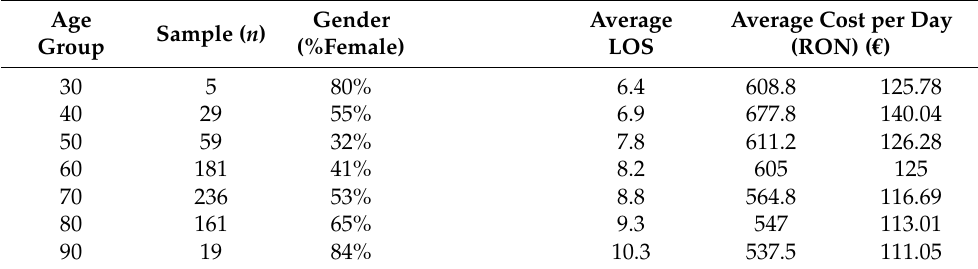
Table 2. Gender, length of stay (LOS) and cost of first-ever AIS patients treated at CEH in 2019 by age